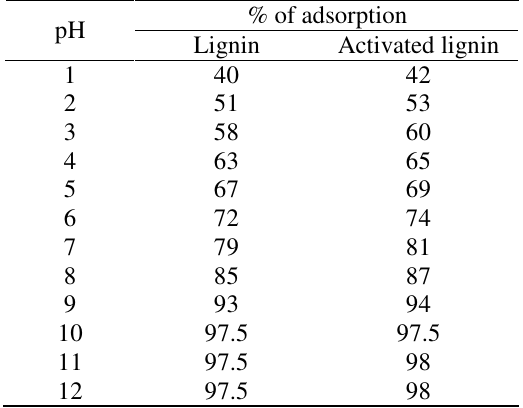
Table 3 . Optimization of